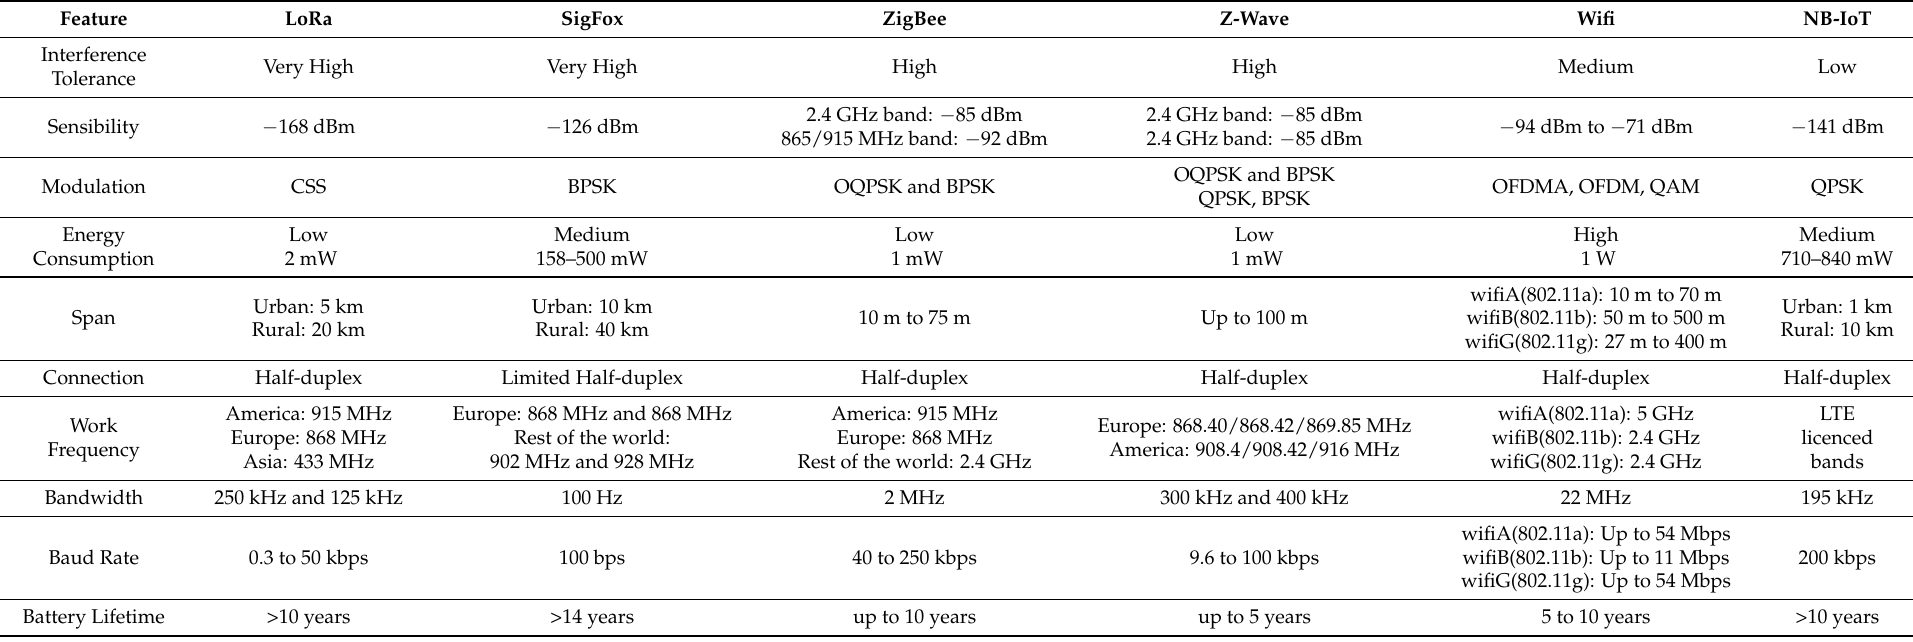
Table 1. Characteristics of Common Technologies in IoT-based